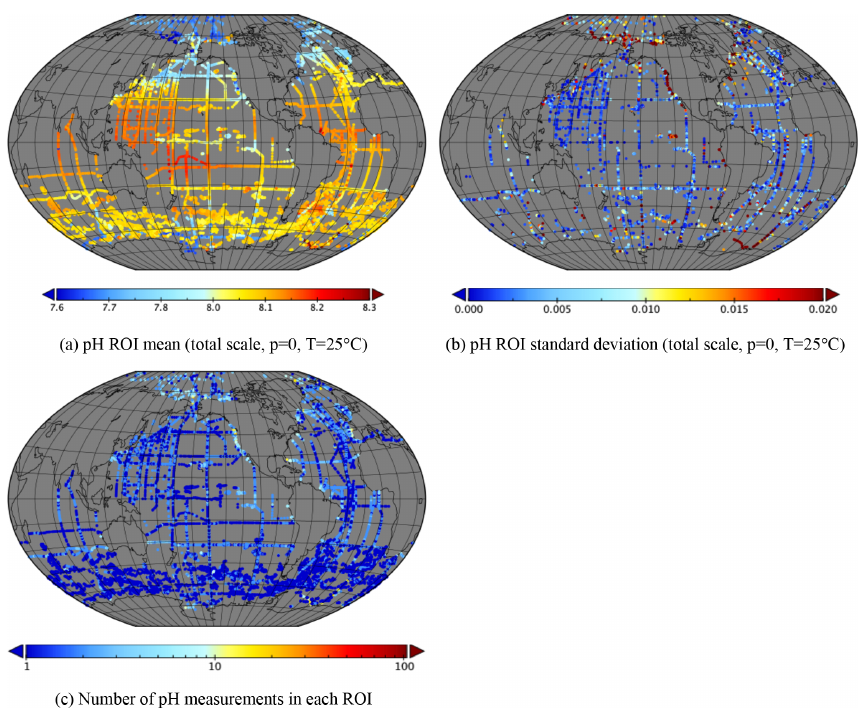
Figure 6. Statistics of pH in each ROI over the whole database (19613 ROIs). (a) ROI mean, (b) ROI standard deviation and (c) number of measurements in each